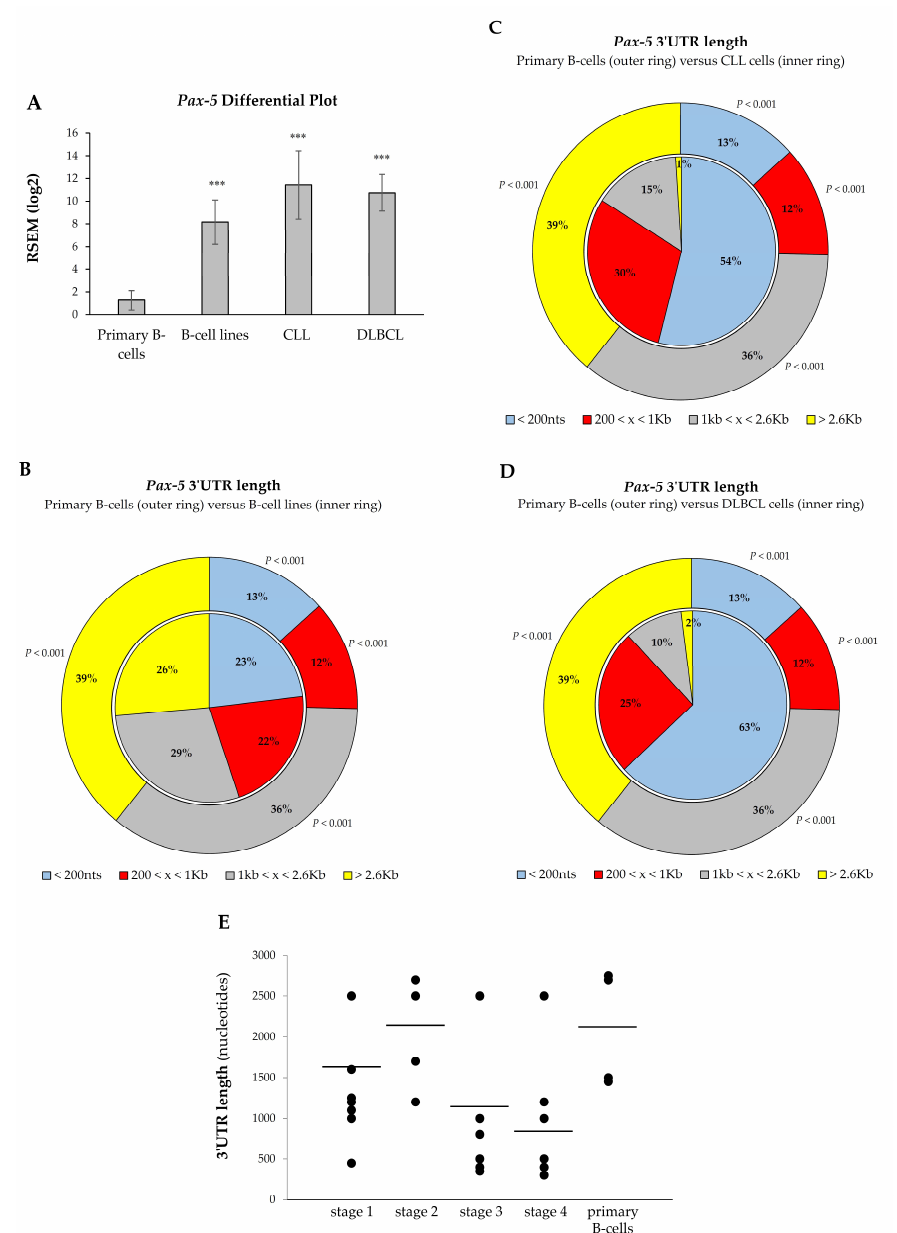
Figure 6. 3 (cid:48) UTR shortening profiles in B-cell cancer lesions. Comparison analyses of ( A ) Pax-5 transcript levels and overall 3 (cid:48) UTR length distribution were determined in ( B ) immortalized B-cell lines, ( C ) chronic lymphocytic leukemia/CLL, and ( D ) diffused large B-cell lymphoma/DLBCL. Compilation of RNA-sequencing data for Pax-5 was obtained from GSE16921 immortal B-cell data set ( n = 41), GSE66117 CLL data set ( n = 47), and TCGA-DLBCL data set ( n = 48) versus two normal B-cell data sets GSE62246 ( n = 2) and GSE70830 ( n = 5), which were used as control samples (outer ring of panels B, C, and D). The read counts of these data sets were estimated by RSEM package (RNA-seq by expectation maximization). The asterisk and text indicate statistical differences by t -test analyses with respect to normal B-cell control samples (*** p < 0.001). ( E ) The Pax-5 3 (cid:48) UTR length was determined by RT-PCR in primary B-lymphocytes isolated from healthy donors ( n = 7) and patients ( n = 17) suffering from B-cell cancer lesions (Supplementary Table S4). The lengths of PCR-amplified products were then measured and plotted according to patients’ clinical disease staging. The average 3 (cid:48) UTR lengths in each category are indicated (black